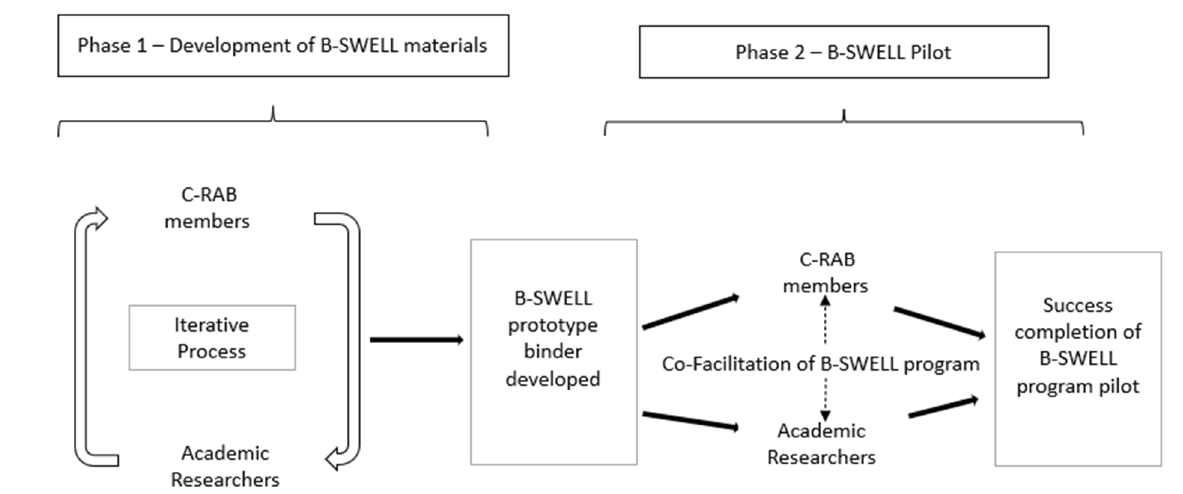
Figure 1. Collaborative research